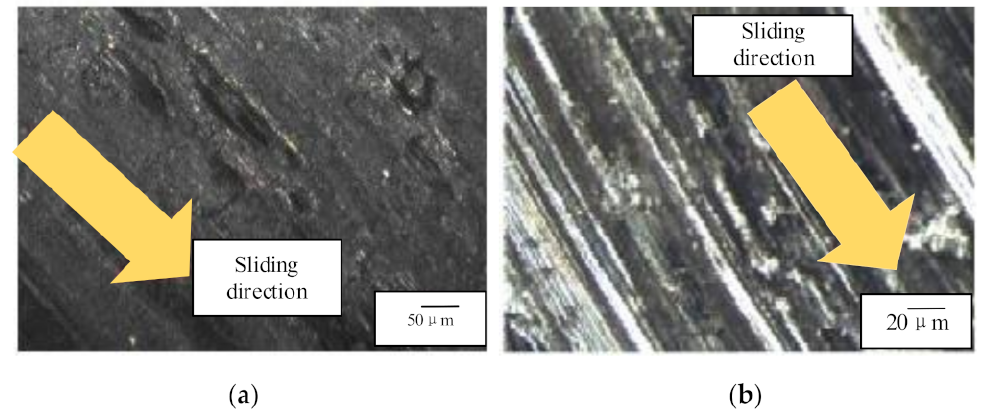
Figure 8. Surface microscopic images: ( a ) pin and ( b ) disc.